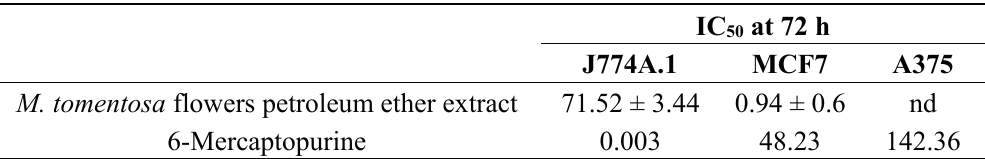
Table 2. In vitro anti-proliferative activity of M. tomentosa flowers petroleum ether extract against J774.A1 macrophages, MCF-7 human breast cancer and A375 human melanoma cells after 72 h of